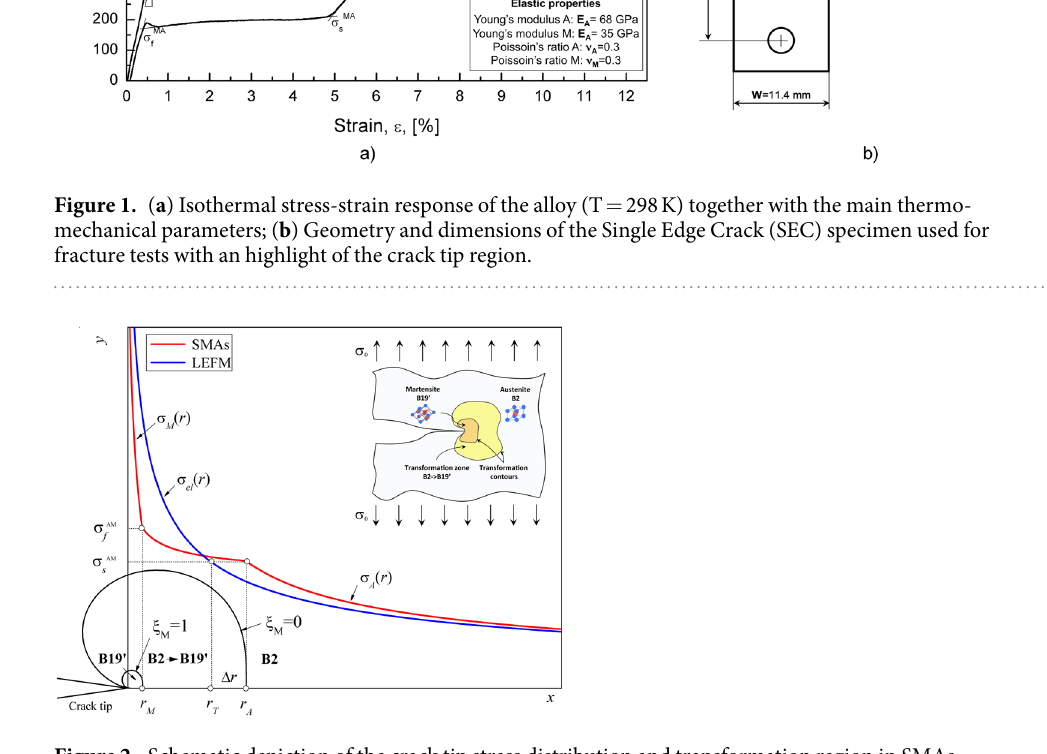
Figure 2. Schematic depiction of the crack tip stress distribution and transformation region in